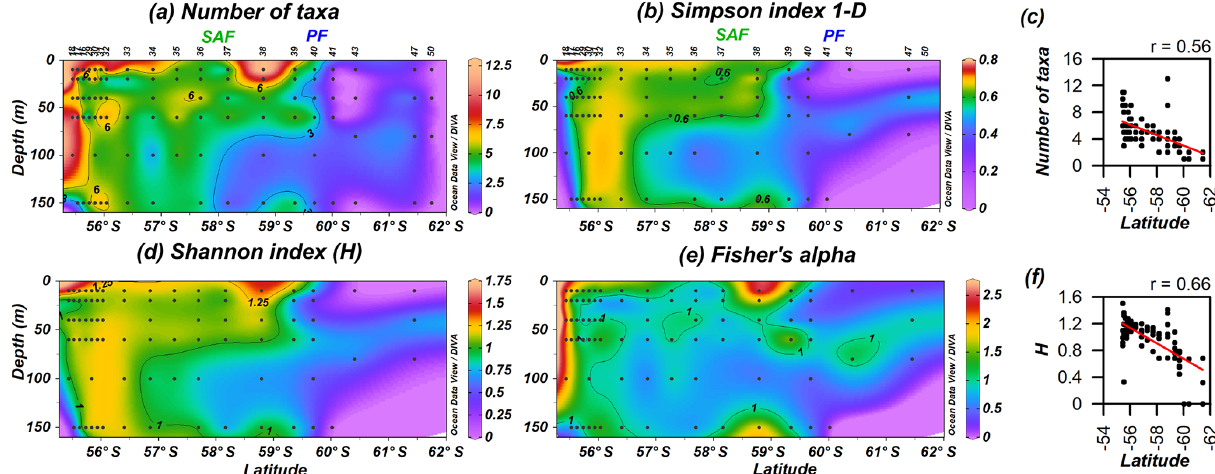
Figure 9. PS97 latitudinal transects showing coccolithophore diversity: (a) number of taxa, (b) Simpson index 1 − D , (c) number of taxa vs. latitude, (d) Shannon index ( H ), (e) Fisher’s alpha and (f) H vs. latitude. The Subantarctic Front (SAF) and the Polar Front (PF), according to Orsi et al. (1995), are